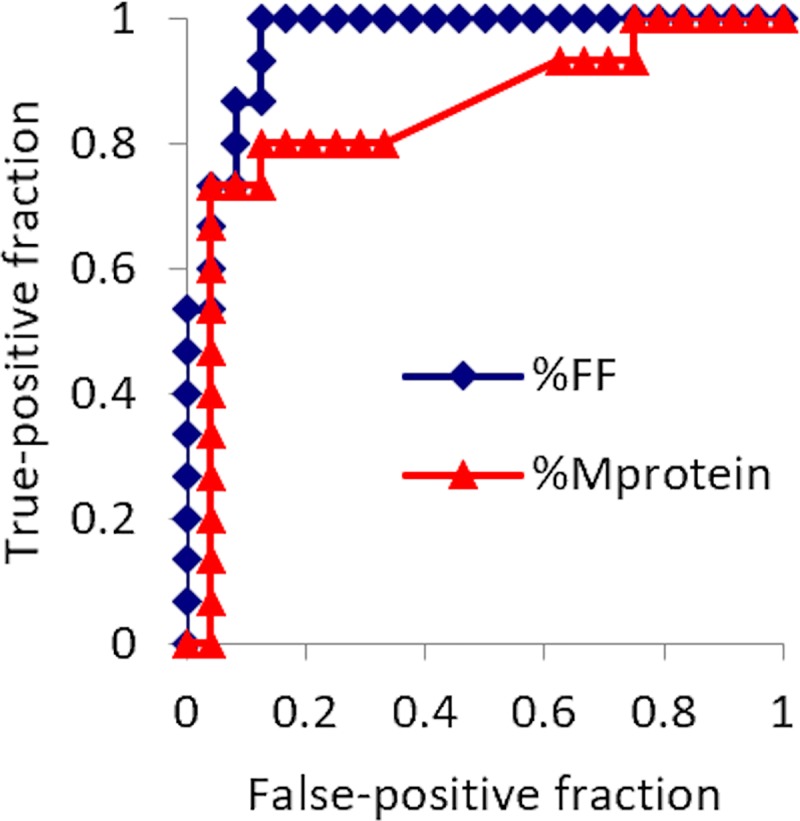
Receiver operating characteristics (ROC) curve for fat fraction (FF) of lumbar bone marrow by mDixon Quant sequence and serum M protein for predicting achievement of CR/VGPR.Areas under the ROC curve are 0.964 for FF and 0.847 for M protein.